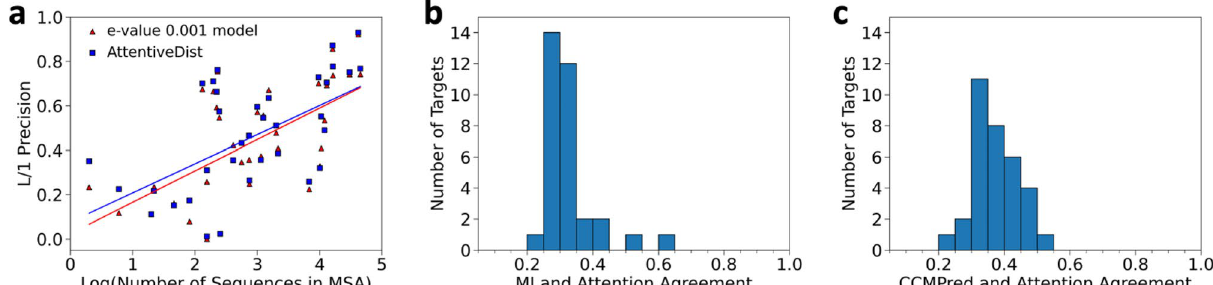
Figure 5. Analysis of the MSA size and the attention. ( a ) Relationship between log of the sequence counts in MSAs and long-range L/1 contact precision for the 43 CASP13 targets. AttentionDist (blue) and the E-value 0.001 model (red), where E-value 0.001 was used as a cutoff for generating MSAs. The lines represent the regression. ( b ) the fraction of residue pairs where the MSA with the highest attention agreed with the MSA with the highest mutual information (MI). The number of targets among the 35 CASP13 target proteins that have the particular fraction of agreed residue pairs were counted for each bin. 43 FM and FM/TBM CASP13 target domains belong to 35 proteins. Out of the 35 proteins, two proteins were discarded from this analysis because the four MSAs with different E-value cutoffs of these proteins were identical. ( c ) the agreement is compared with the contact probability computed from the four MSAs with